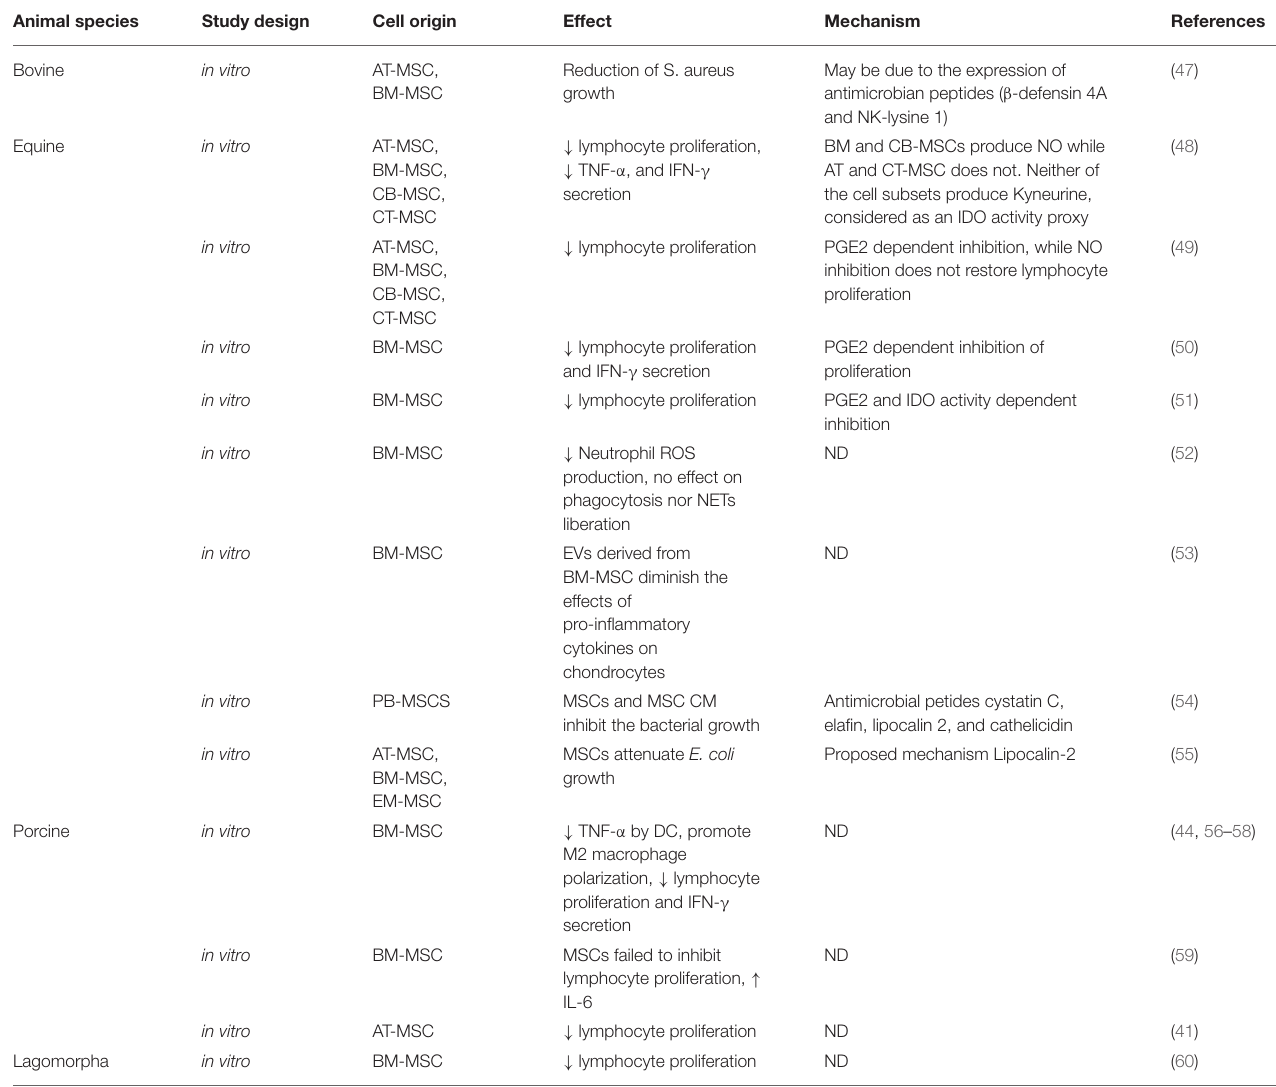
TABLE 2 | In vitro studies that explore antiinflammatory/immunomodulatory mechanisms and effects of MSCs in livestock. Animal